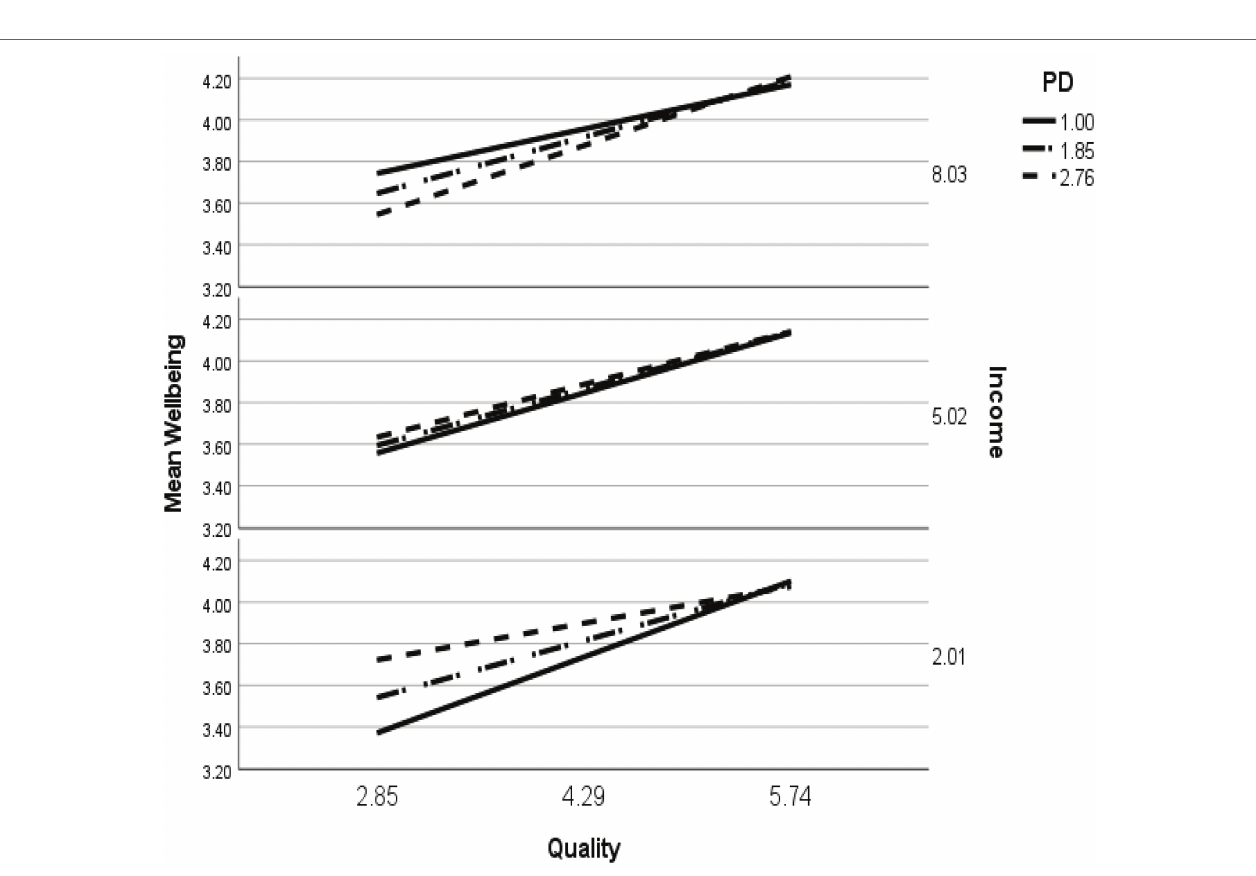
FIGURE 5 | Simple slopes of PQI predict academic well-being for values of income and PD at 1 SD below the mean, the mean, and 1 SD above the mean for students from the United States.